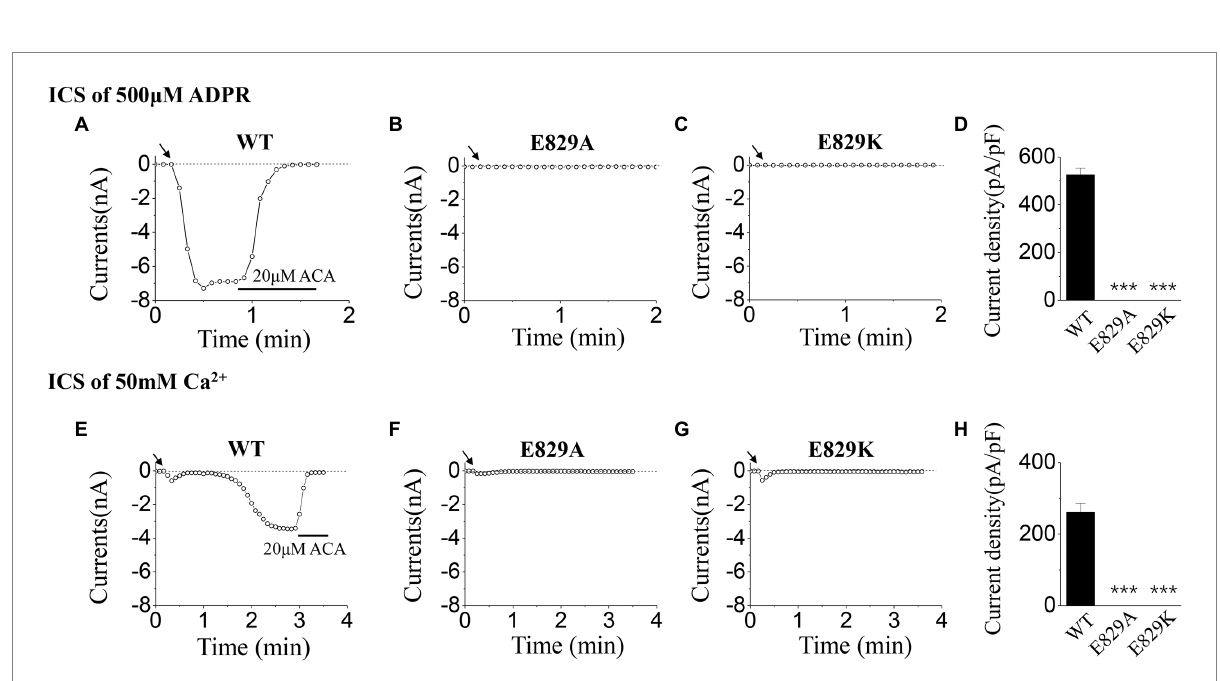
FIGURE 5 Functional assay of WT TRPM2 and mutants at E829. (A–C) Representative whole-cell recordings of TRPM2 channel currents induced by ICS of 500 μ M ADPR from HEK293T cells expressing (A) WT, (B) E829A, (C) E829K, and (D) Summary of the current density induced in cells expressing WT and mutants. In each case, six cells were tested. (E–H) Representative whole-cell recordings of TRPM2 channel currents induced by ICS of 50 mM Ca 2+ from HEK293T cells expressing (E) WT, (F) E829A, (G) E829K, and (H) Summary of the current density induced in cells expressing WT and mutants. The arrow in each panel indicates the time point at which whole cell configuration was established. In each case, six cells were tested. *** p < 0.001 compared with WT.